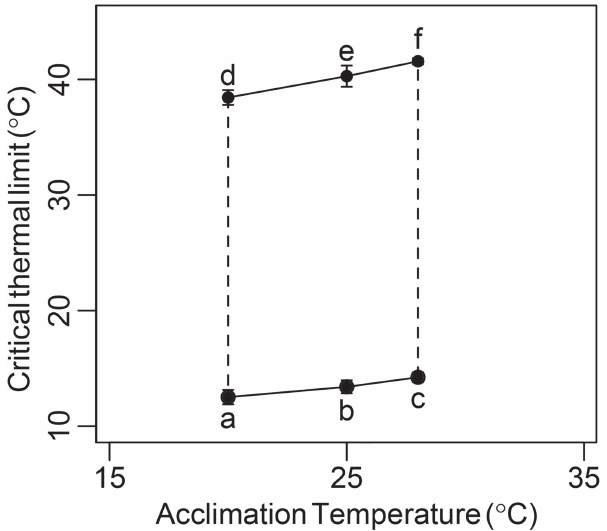
Fig. 1. Thermal tolerance limits of Poecilia caucana . Values represent mean ± SD in critical thermal limits estimated for each acclimation temperature. Letters represent significant differences in the Tukey post-hoc test using